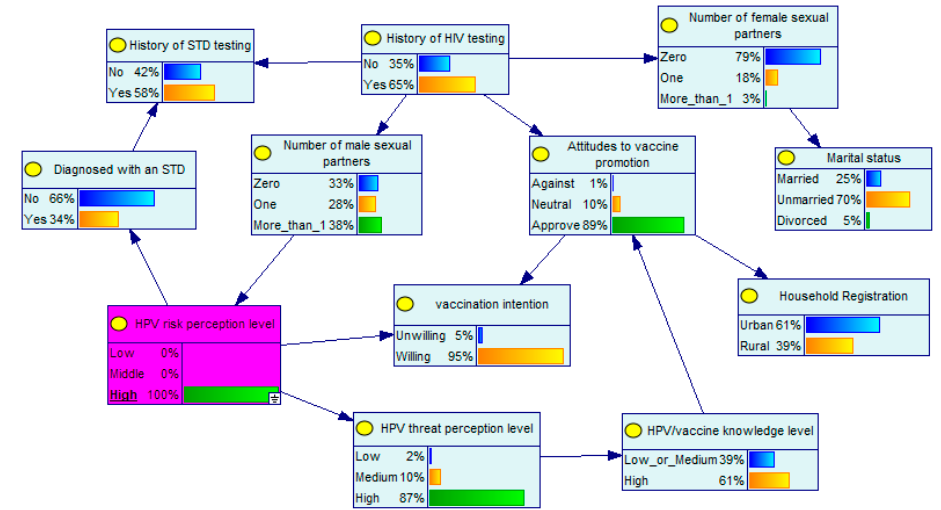
Figure 2. Bayesian network with known node probabilities I.